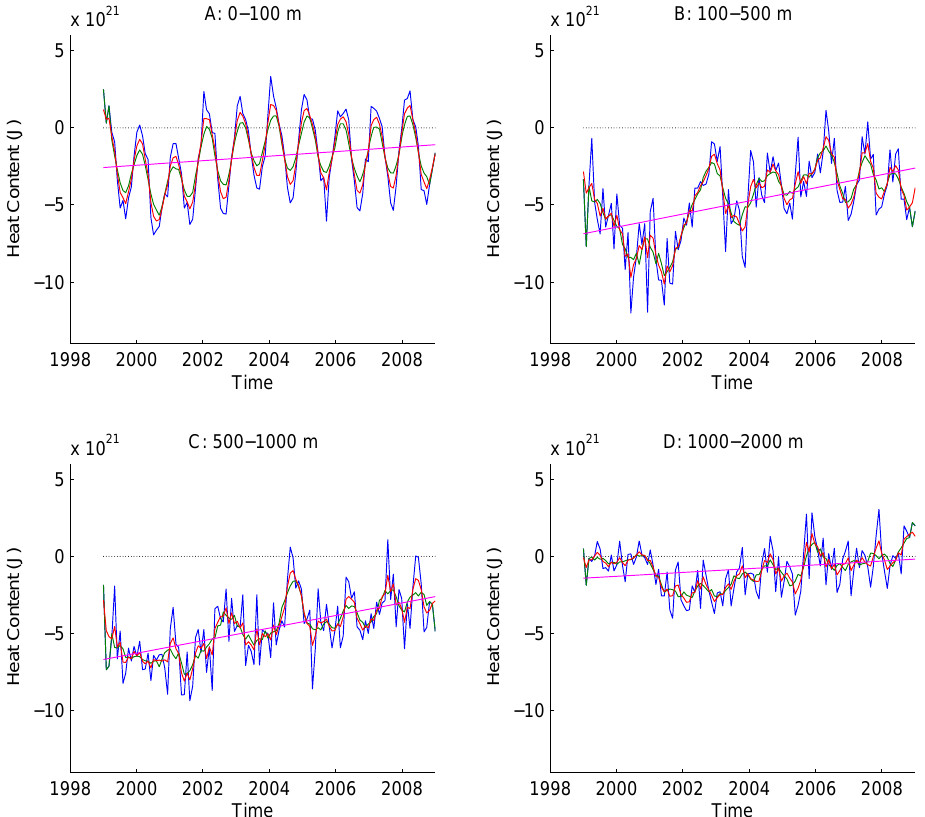
Fig. 10. HCD time series for the North Atlantic in selected layers: (a) 0–100m; (b) 100–500m; (c) 500–1000m; (d) 1000–2000m;